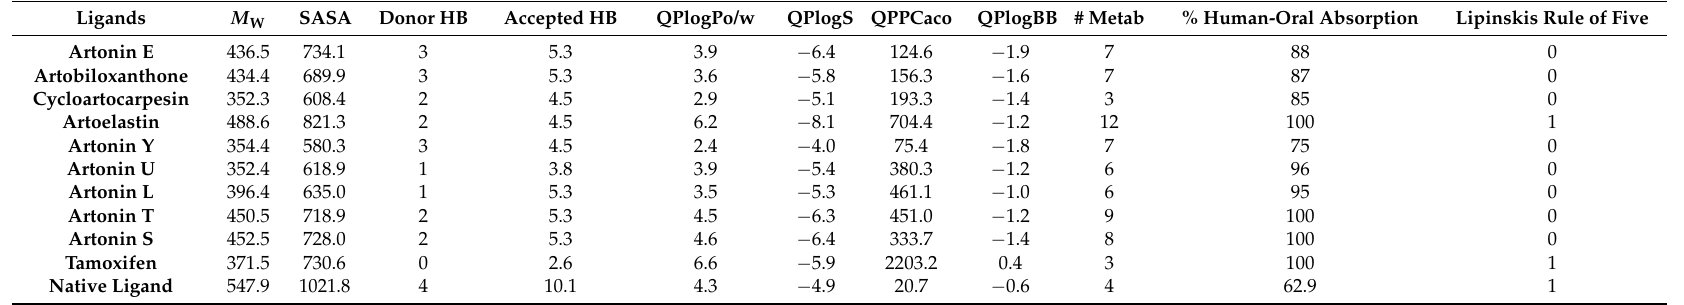
Range for 95% known drugs: Molecular weight ( M W ) = 130.0–725.0; Total solvent accessible surface area (SASA) = 300.0–1000.0; Donor HB = 0.0–6.0; Accept HB = 2.0–20.0; Predicted octanol/water partition coefficient (QPlogPo/w) = ´ 2.0–6.5; Predicted aqueous solubility (QPlogS) = ´ 6.5–0.5; Predicted apparent Caco-2 cell permeability (QPPCaco) ď 25 poor, >500 great; Predicted brain/blood partition coefficient (QPlogBB) = ´ 3.0–1.2; Number of likely metablioc reactions (# metab) = 1–8; % Human oral absorption ě 80% Ñ High, <25% Ñ Poor; Number of violations of Lipinskis Rule of Five; mol MW < 500, QPlogPo/w < 5, donor HB ď 5, accpt HB ď 10. Compounds that satisfy these rules are considered